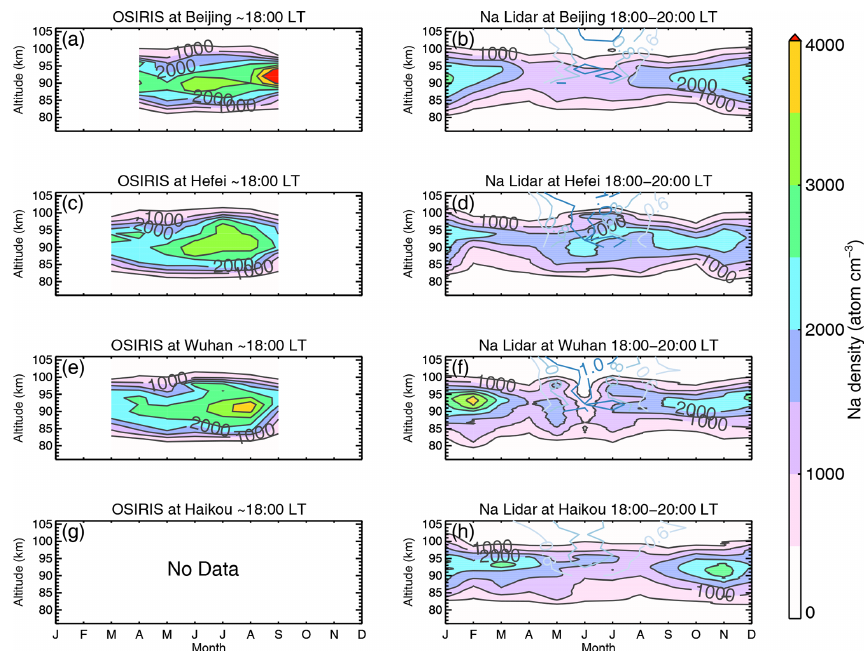
Figure 11. Comparisons of monthly mean of Na number density in the evening, from OSIRIS at about 18:00LT (ascending node) and Na lidars at 18:00–20:00LT (a–b) at Beijing, (c–d) Hefei, (e–f) Wuhan, and (g–h) Haikou.